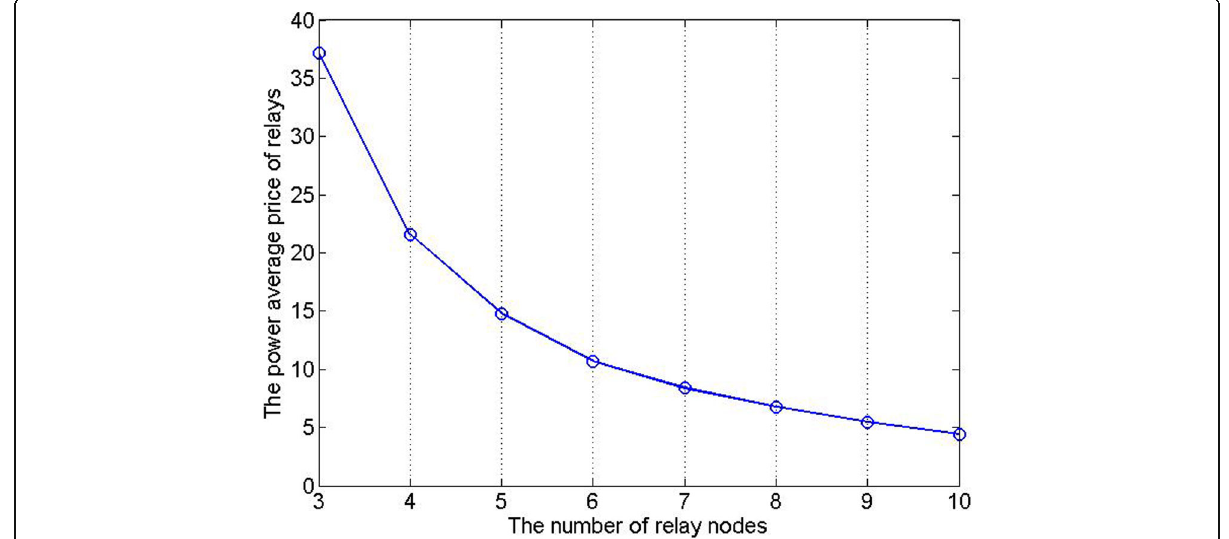
Fig. 9 The average power price of relay nodes Vs the number of cooperative relay